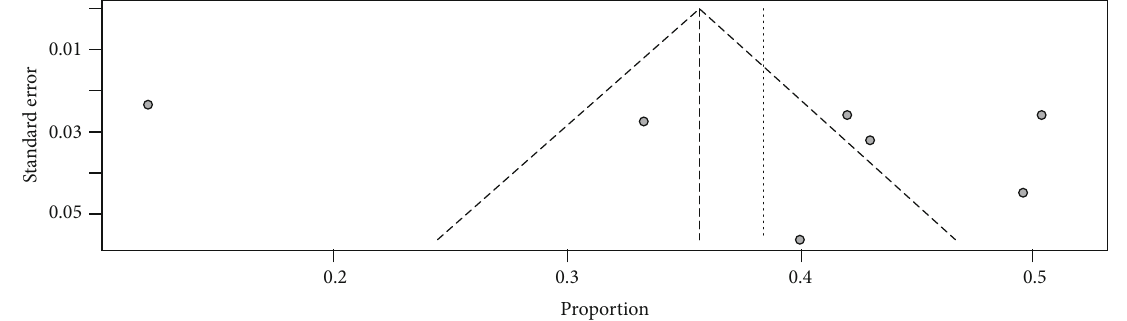
Figure 4: Funnel plot showing evidence of publication bias across the